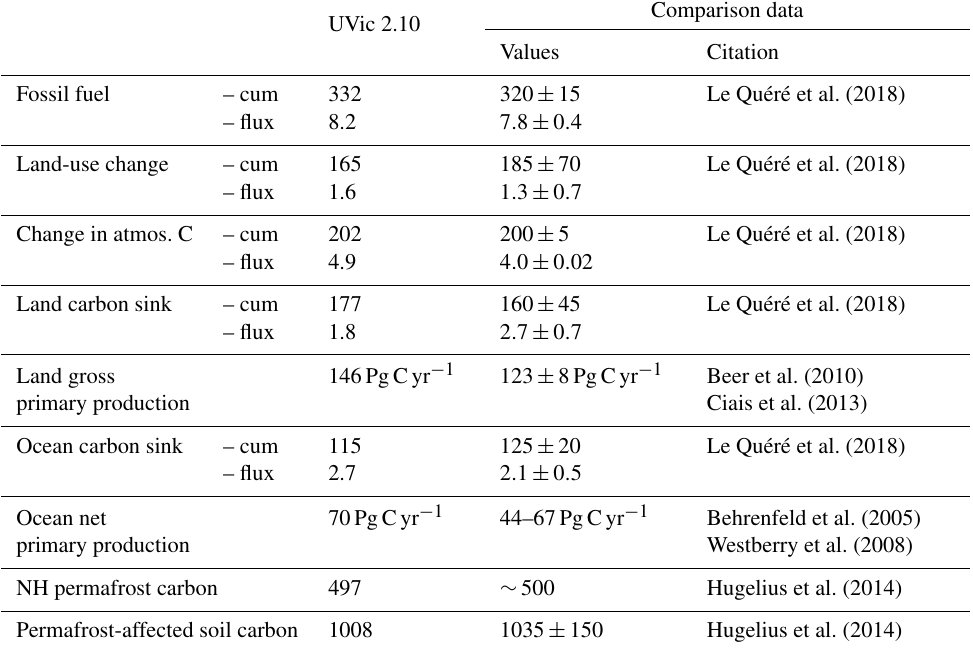
Table 2. Global carbon cycle fluxes for the year 2005 (in PgCyr − 1 ) (– flux) or cumulated fluxes between 1850 and 2005 (in PgC) (– cum) from the UVic ESCM 2.10 compared to data-based estimates from the Global Carbon Project 2018 and the IPCC AR5 Chap. 6. Note the observational estimates of the carbon stocks are calculated from 1750 to